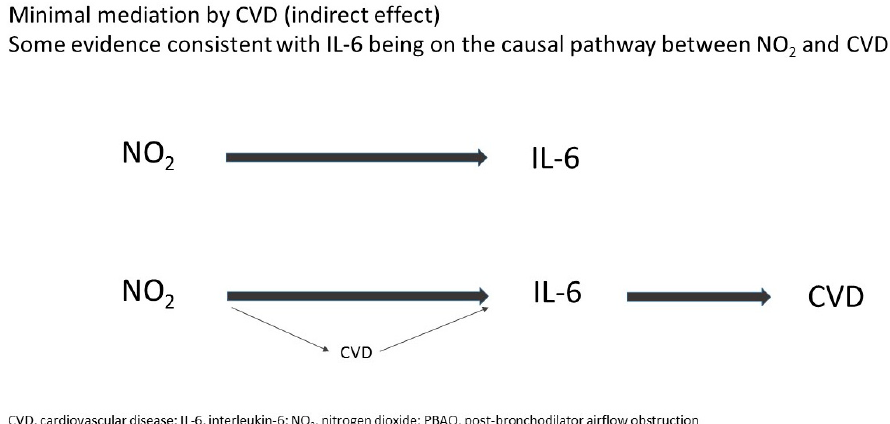
Figure A1. Potential representation of NO 2 exposure, systemic IL-6 concentrations and its relationships with post-BD airflow obstruction and cardiovascular disease.